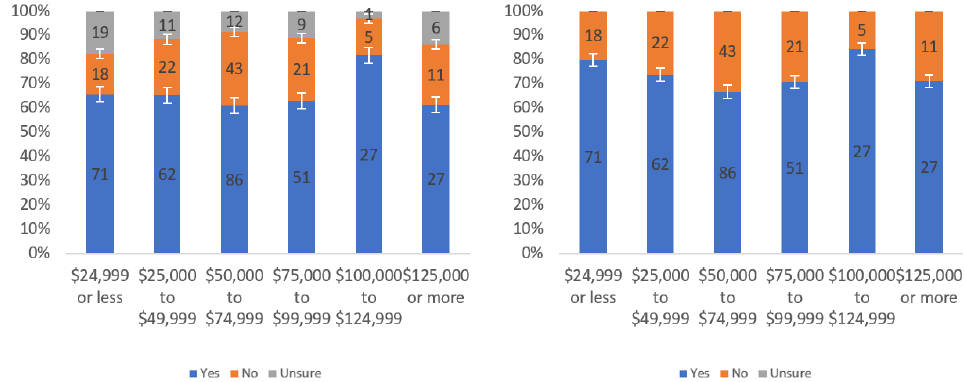
Figure A31. Responses regarding label helpfulness by income level including ( left ) and excluding ( right ) unsure responses.